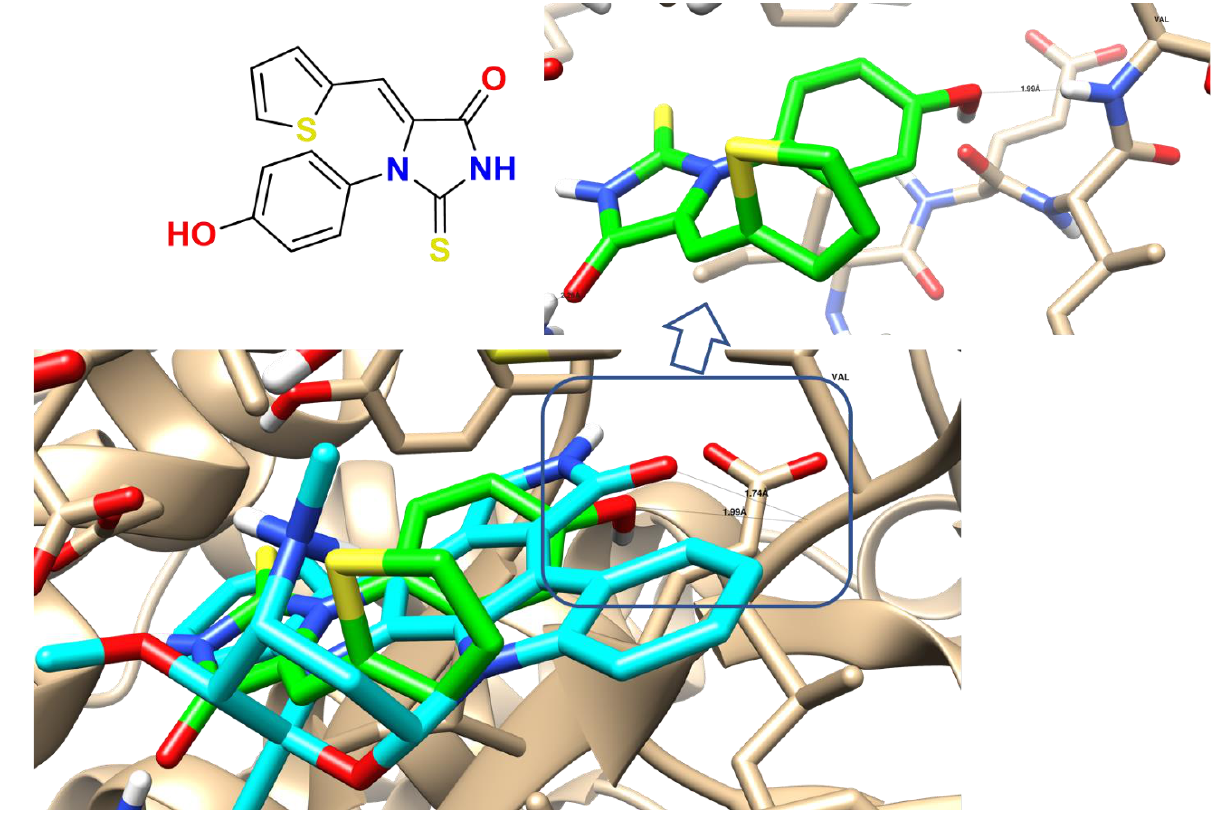
Figure 10. Binding disposition and interactive pose compound 4 (green) and the co-crystalized lig- and (cyan) of the PI3K protein. (cyan) of the PI3K